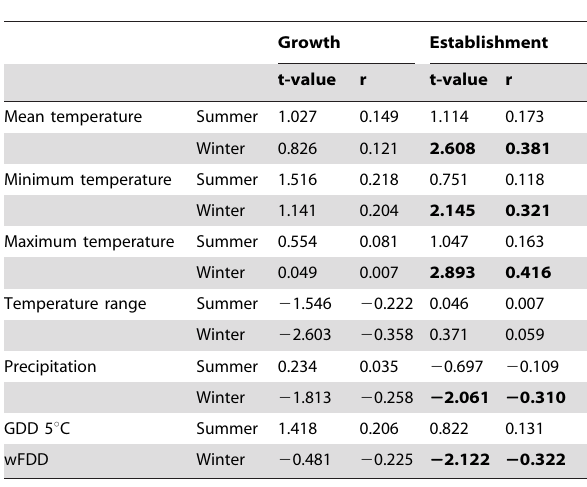
Table 2. Pearson’s product-moment correlations between climate variables and mean site-level annual growth and establishment between 1941 and